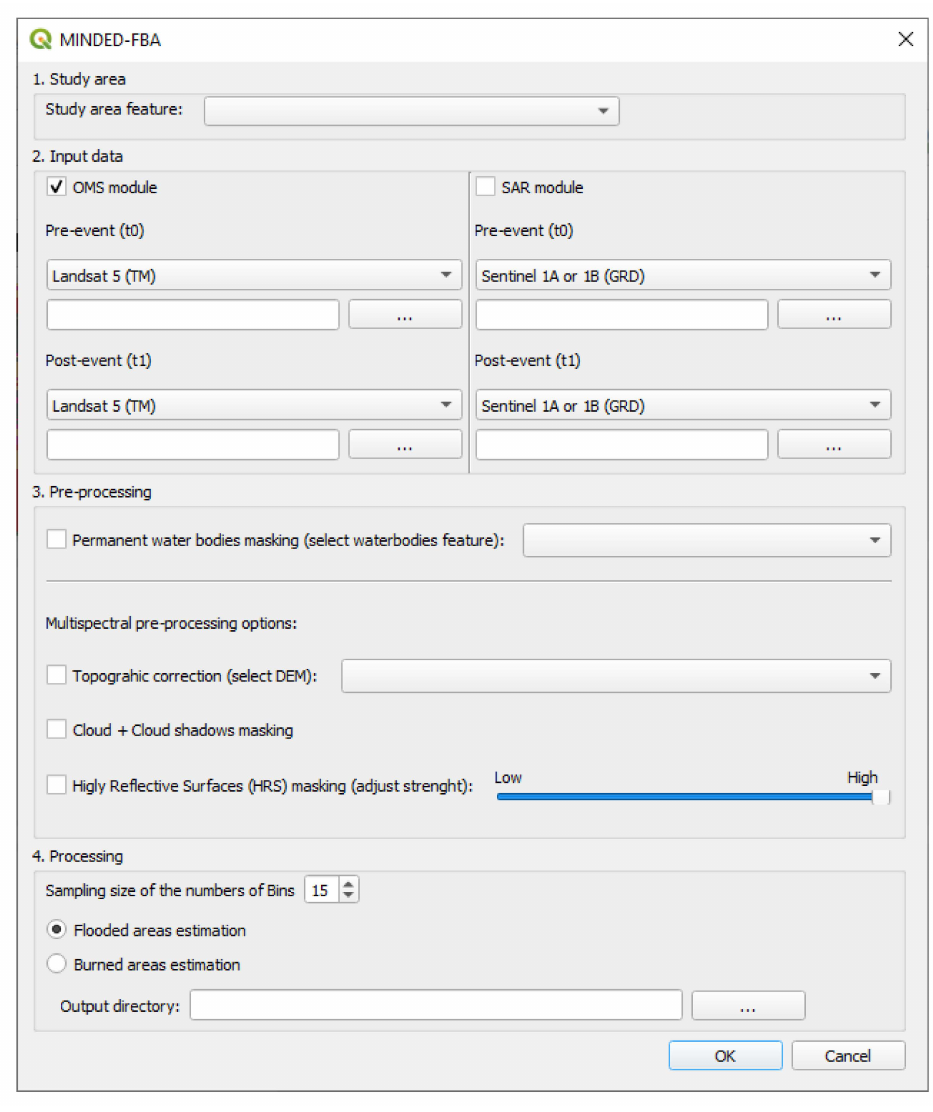
Figure 1. The MINDED-FBA tool graphical